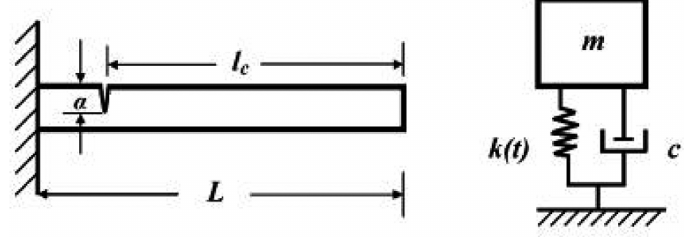
Fig. 1. The cracked cantilever beam and the SDOF lumped parameter